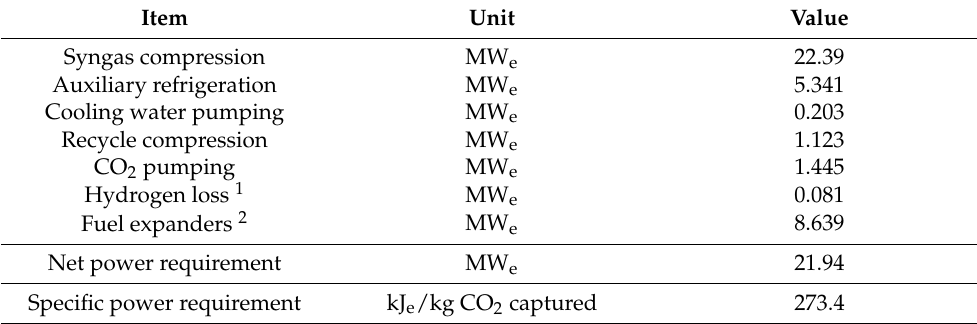
Table 4. Power results for the baseline low-temperature CO 2 capture